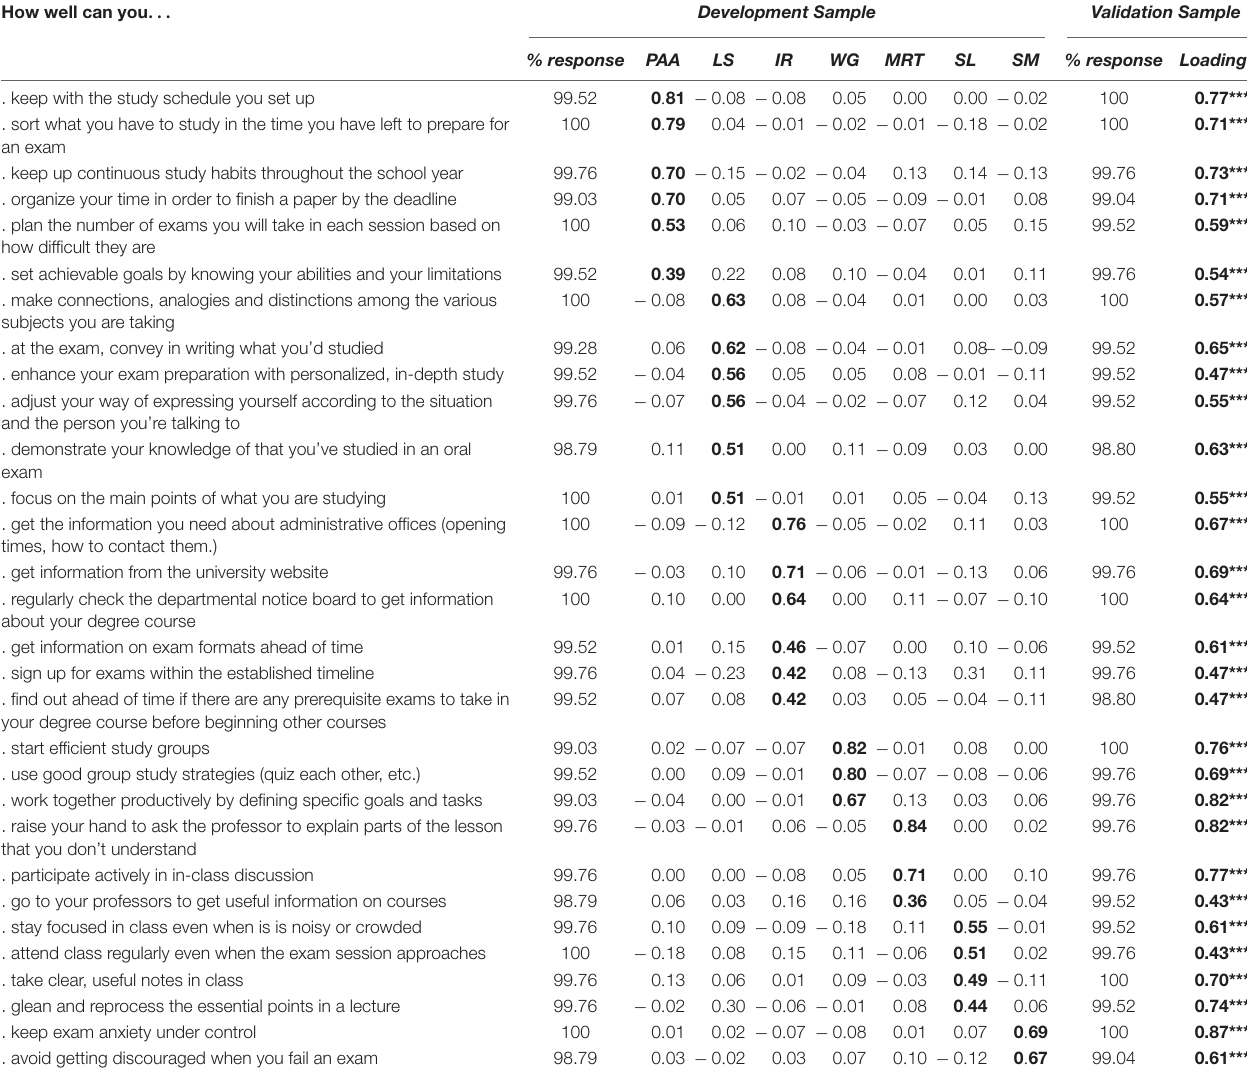
TABLE 1 | Item percentage of response frequency and factors loadings from the Exploratory Factor Analysis in DEVELOPMENT SAMPLE and Confirmatory Factor Analysis in VALIDATION SAMPLE. How well can you ...